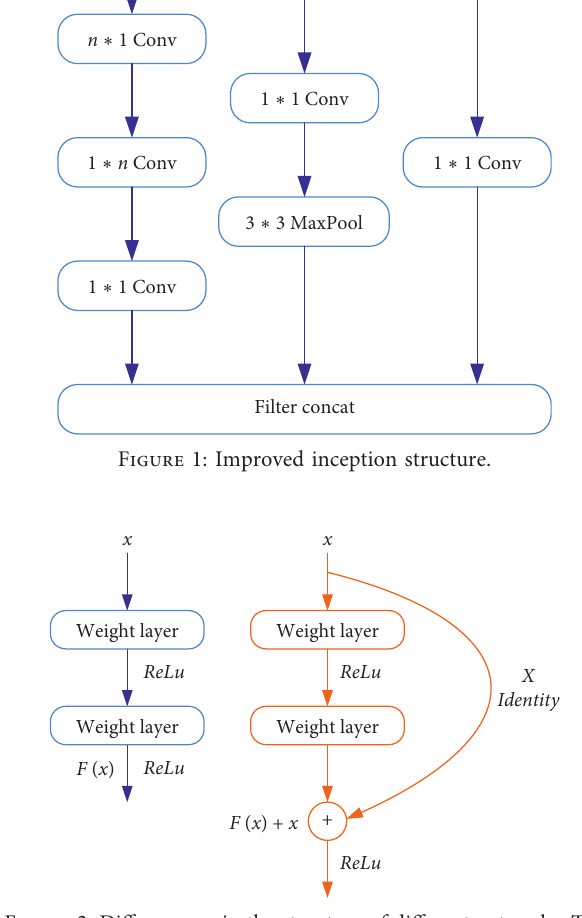
Figure 2: Differences s in the structure of different networks. The left is an ordinary network, and the right is a residual network in